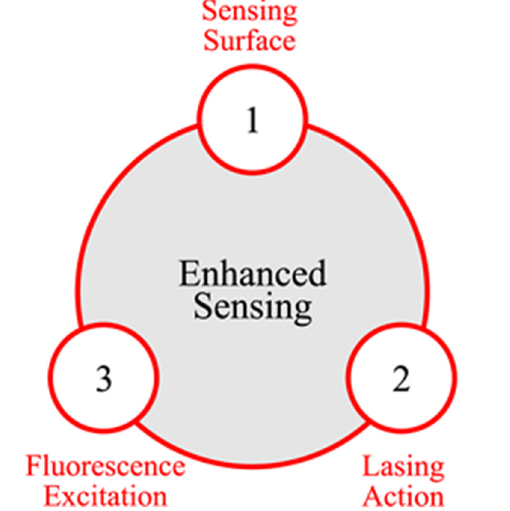
Figure 1. Synoptic illustration of the three main approaches that can be considered for enhancing the limits of detection of fluorescent sensing